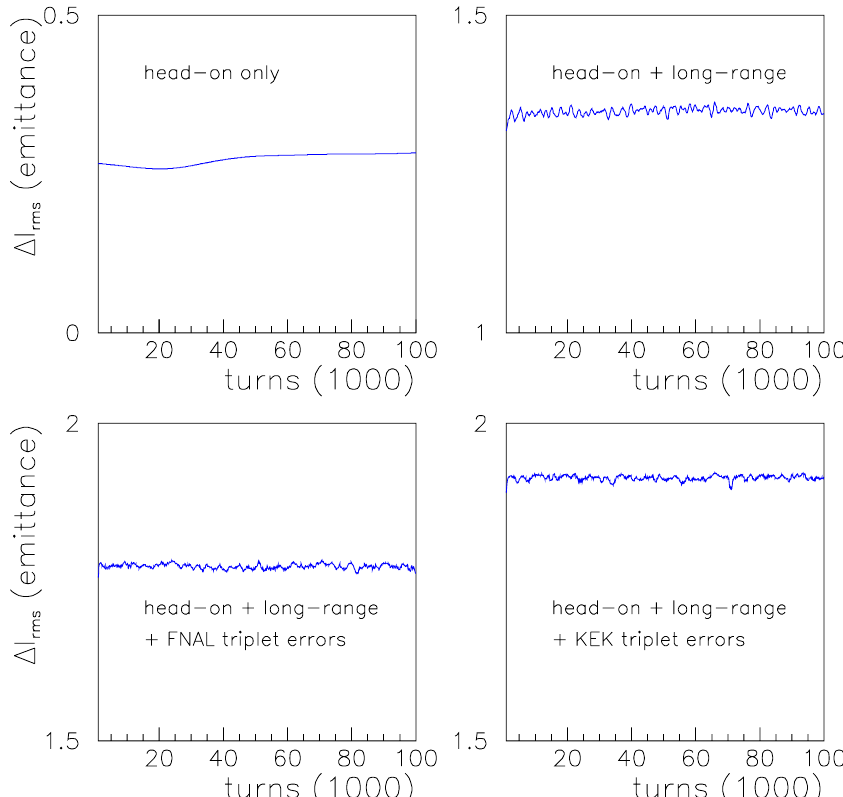
FIG. 6. (Color) The variance in action (in units of rms emittance) for a group of 100 particles as a function of turn number. The particles were launched with identical transverse action corresponding to 5 s x , y in both transverse planes and with random betatron phase. The figure demonstrates the effects of head-on collisions, long-range collisions, and triplet nonlinearities,